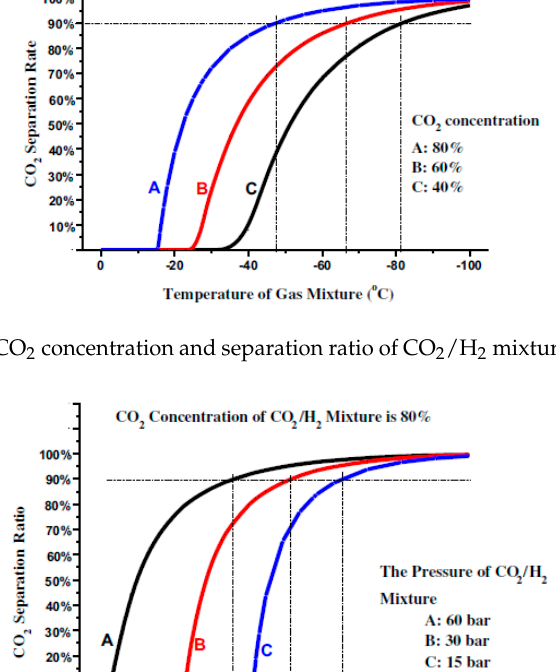
Figure 3. Variation in pressure and separation ratio of CO 2 /H 2 mixture with temperature [8].